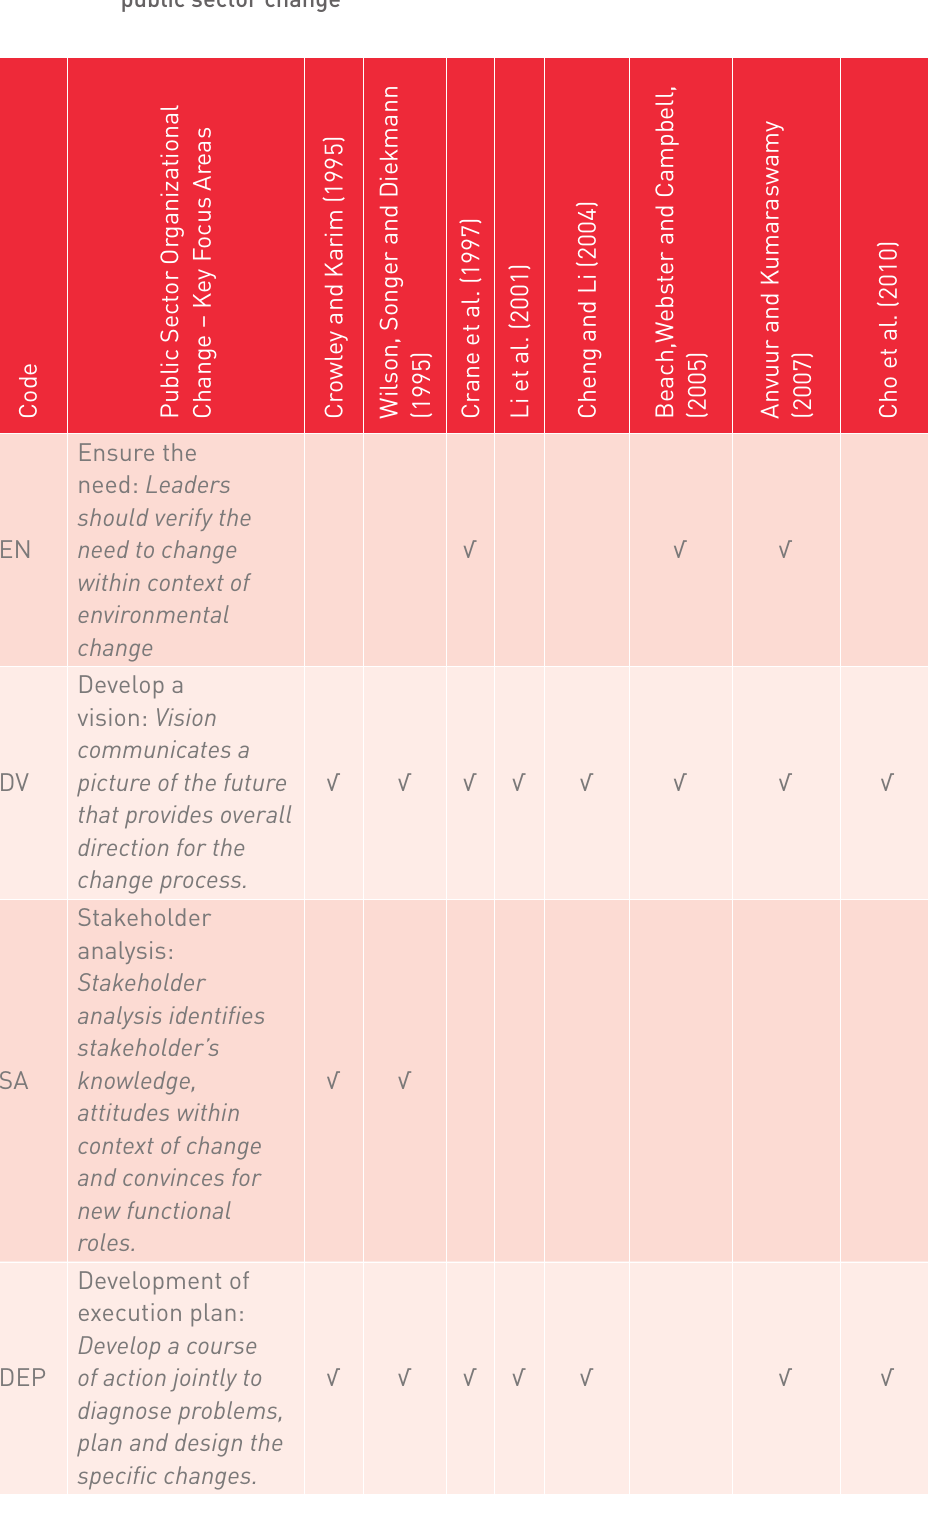
Similarities and differences among RC models against success factors for public sector